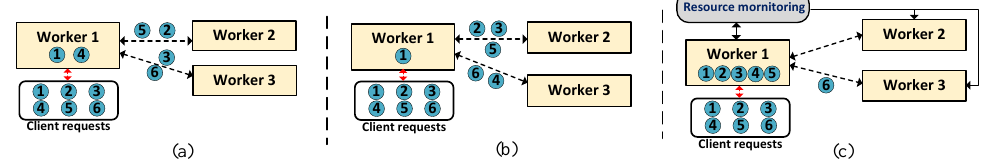
Figure 2. Load-balancing algorithms of the default kube-proxy and RAP : ( a ) round-robin , ( b ) random , and ( c ) RAP